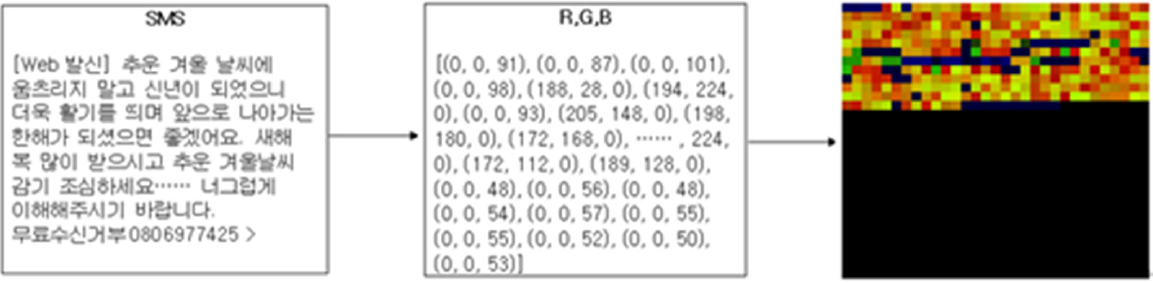
Figure 9. Each character was converted to one pixel of an image.